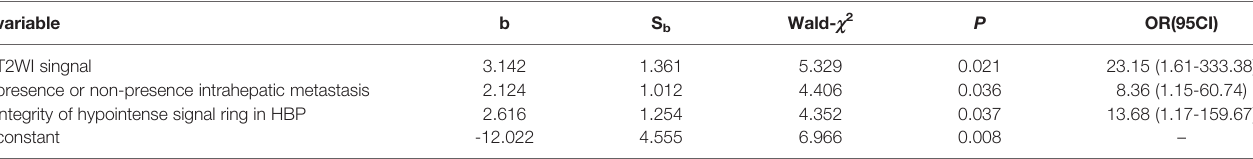
TABLE 4 | Multivariate logistic regression analysis of independent risk factors for pathological grade.